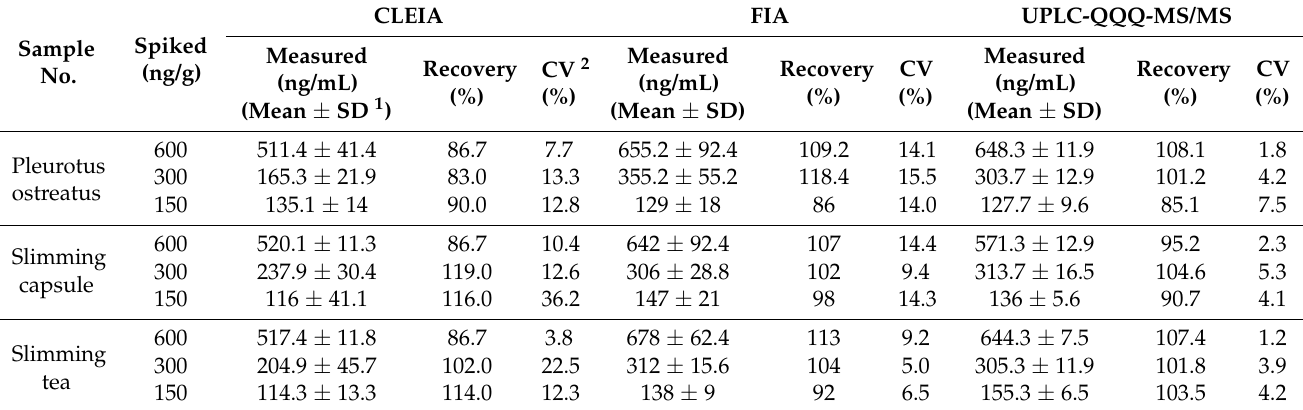
Table 4. Recovery test for CLEIA, FIA, and UPLC-QQQ-MS/MS ( n =